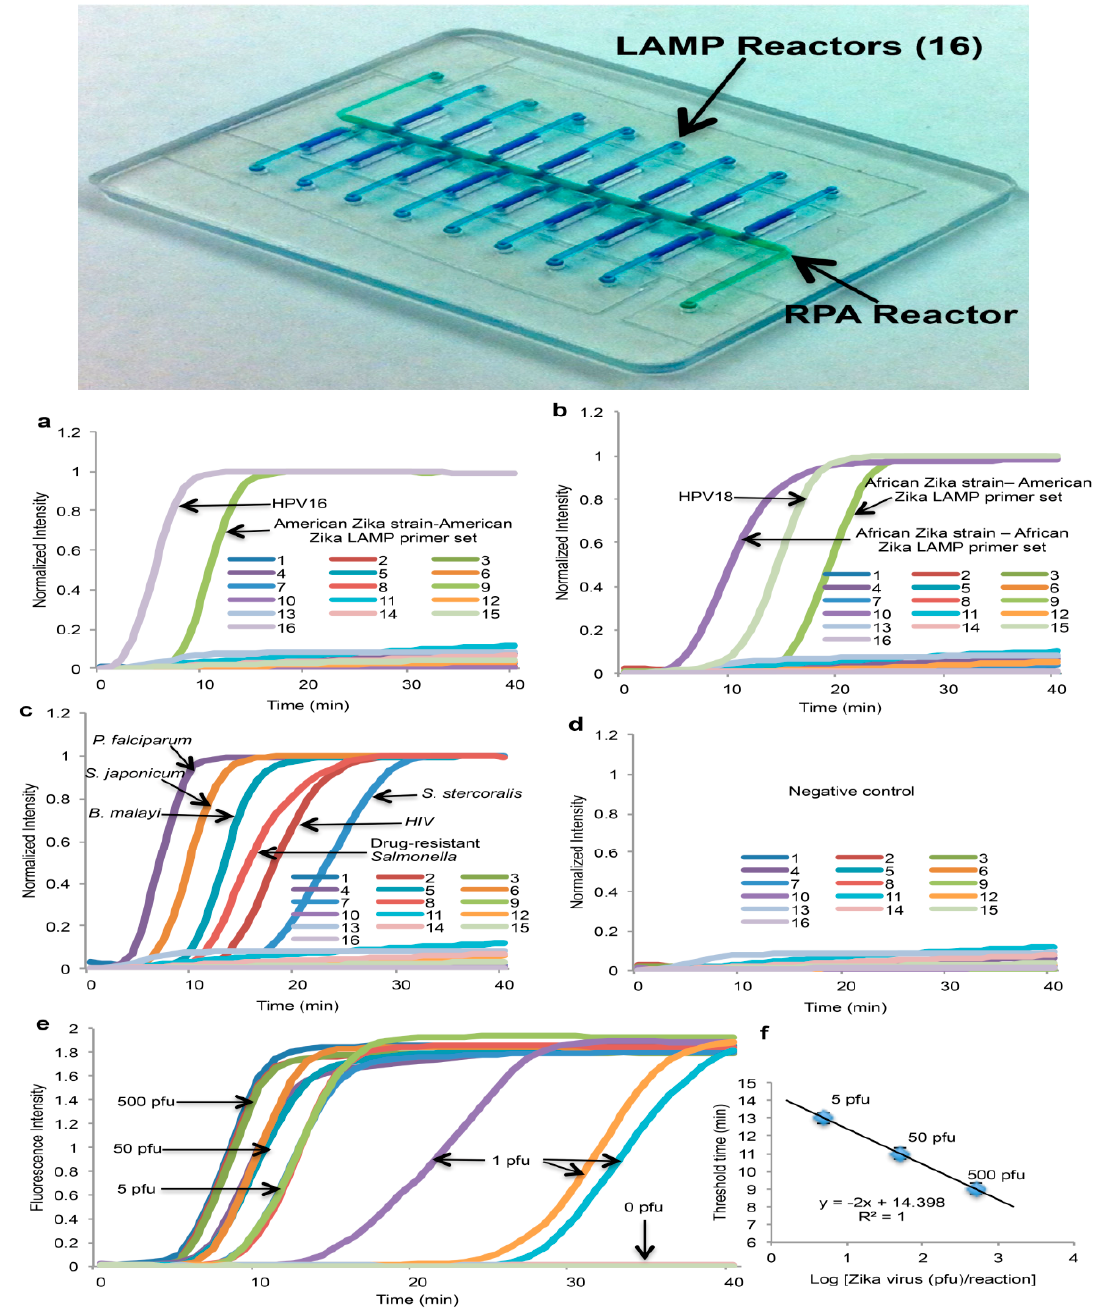
Figure 9. Multiplex two-stage isothermal amplification/detection. Sample is introduced into the center manifold chamber containing primers for up to sixteen different DNA or RNA targets, and amplified with RPA. Top: Chip showing center reactor and 16 branching specific LAMP reactors. Bottom: Graphs showing real-time fluorescence intensity from sixteen LAMP reaction chambers: ( a – c ) Various targets, distributed LAMP chambers; ( d ) negative controls; ( e ) serial dilutions of Zika virus, and ( f ) threshold time vs. Zika template concentration. From [116].